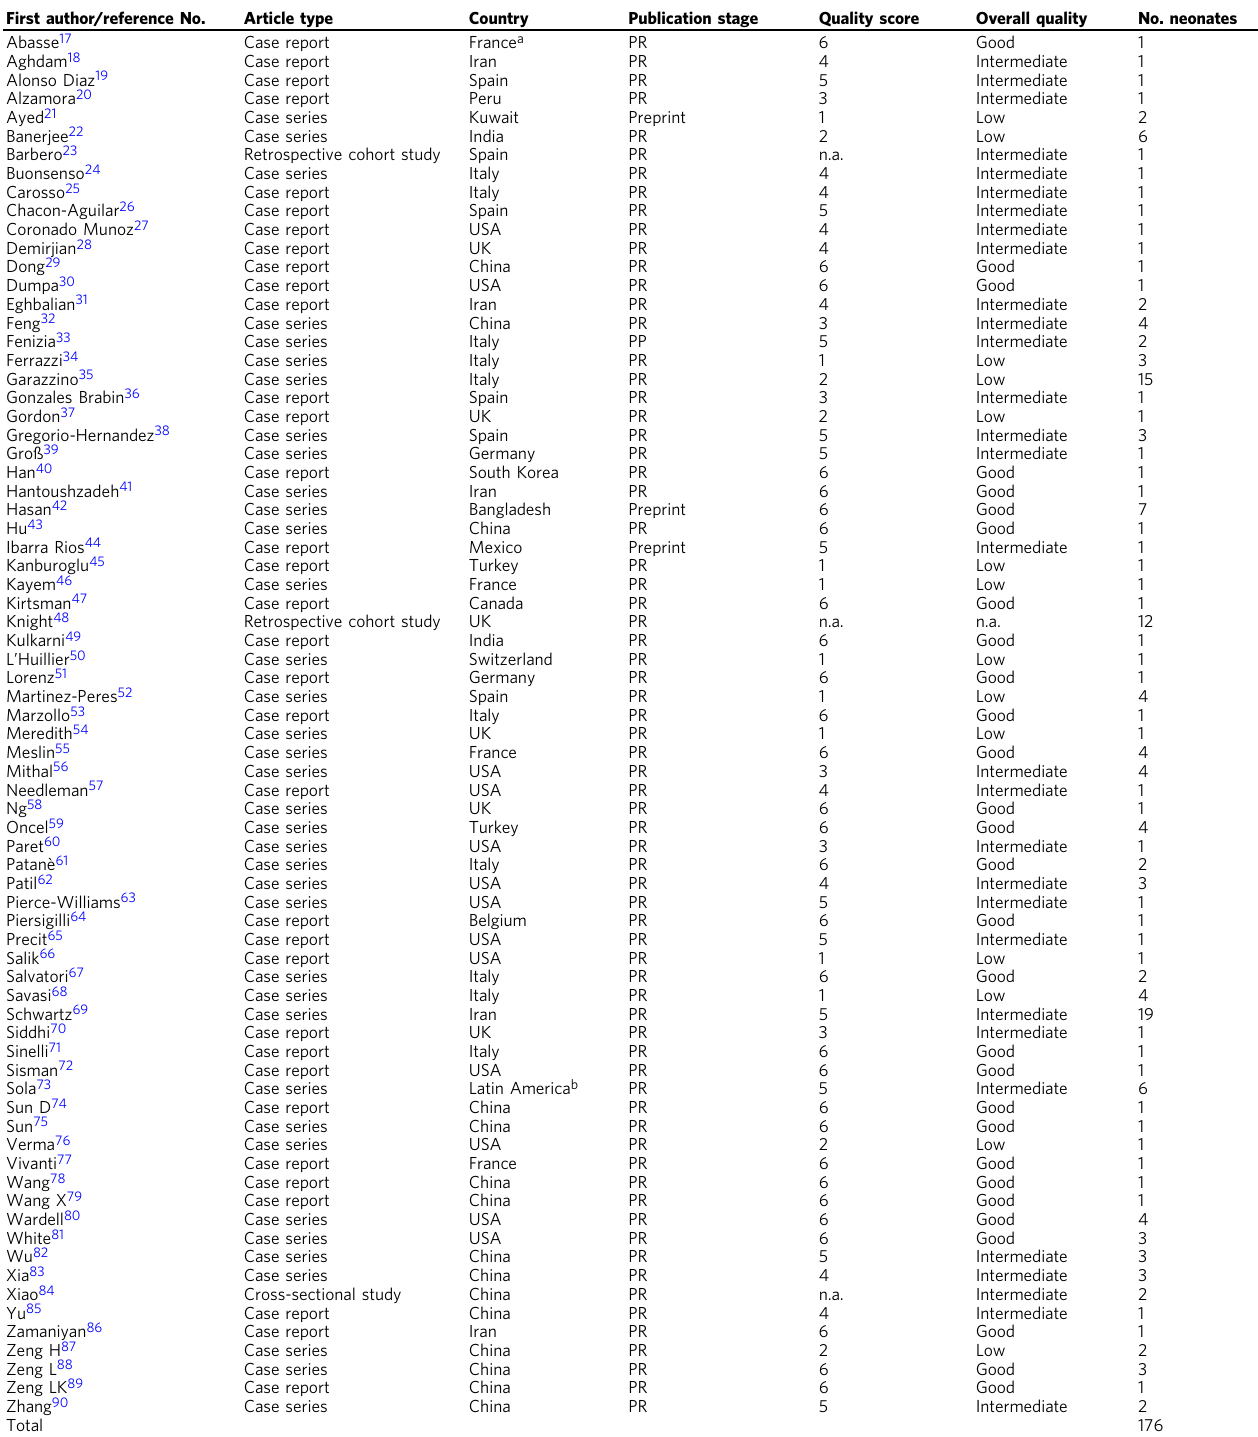
Table 1 Characteristics of articles included in the systematic